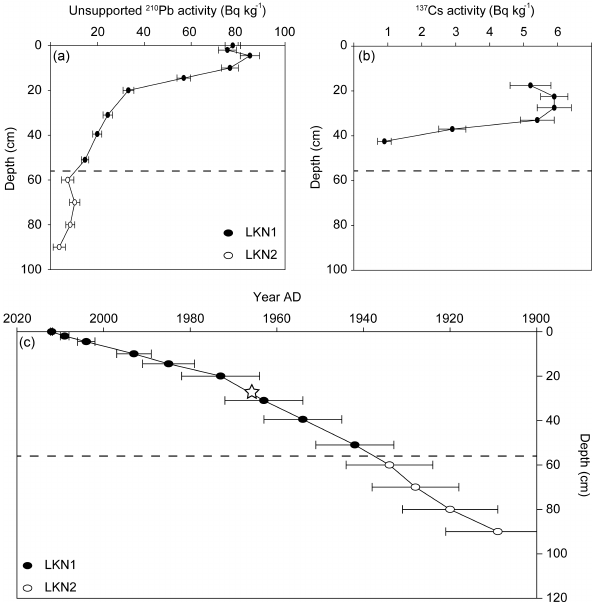
Figure 2. Unsupported 210 Pb activities (Bqkg − 1 sed) versus depth (a) , 137 Cs activities (Bqkg − 1 sed) versus depth (b) and the age depth model based on unsupported 210 Pb values using the CIC (constant initial concentration) model (c) . The star in (c) refers to the depth of the 137 Cs peak activity. LKN1 and LKN2 refer to the two different cores sampled (see methods) and the horizontal dashed line demarcates the transition from core LKN1 to LKN